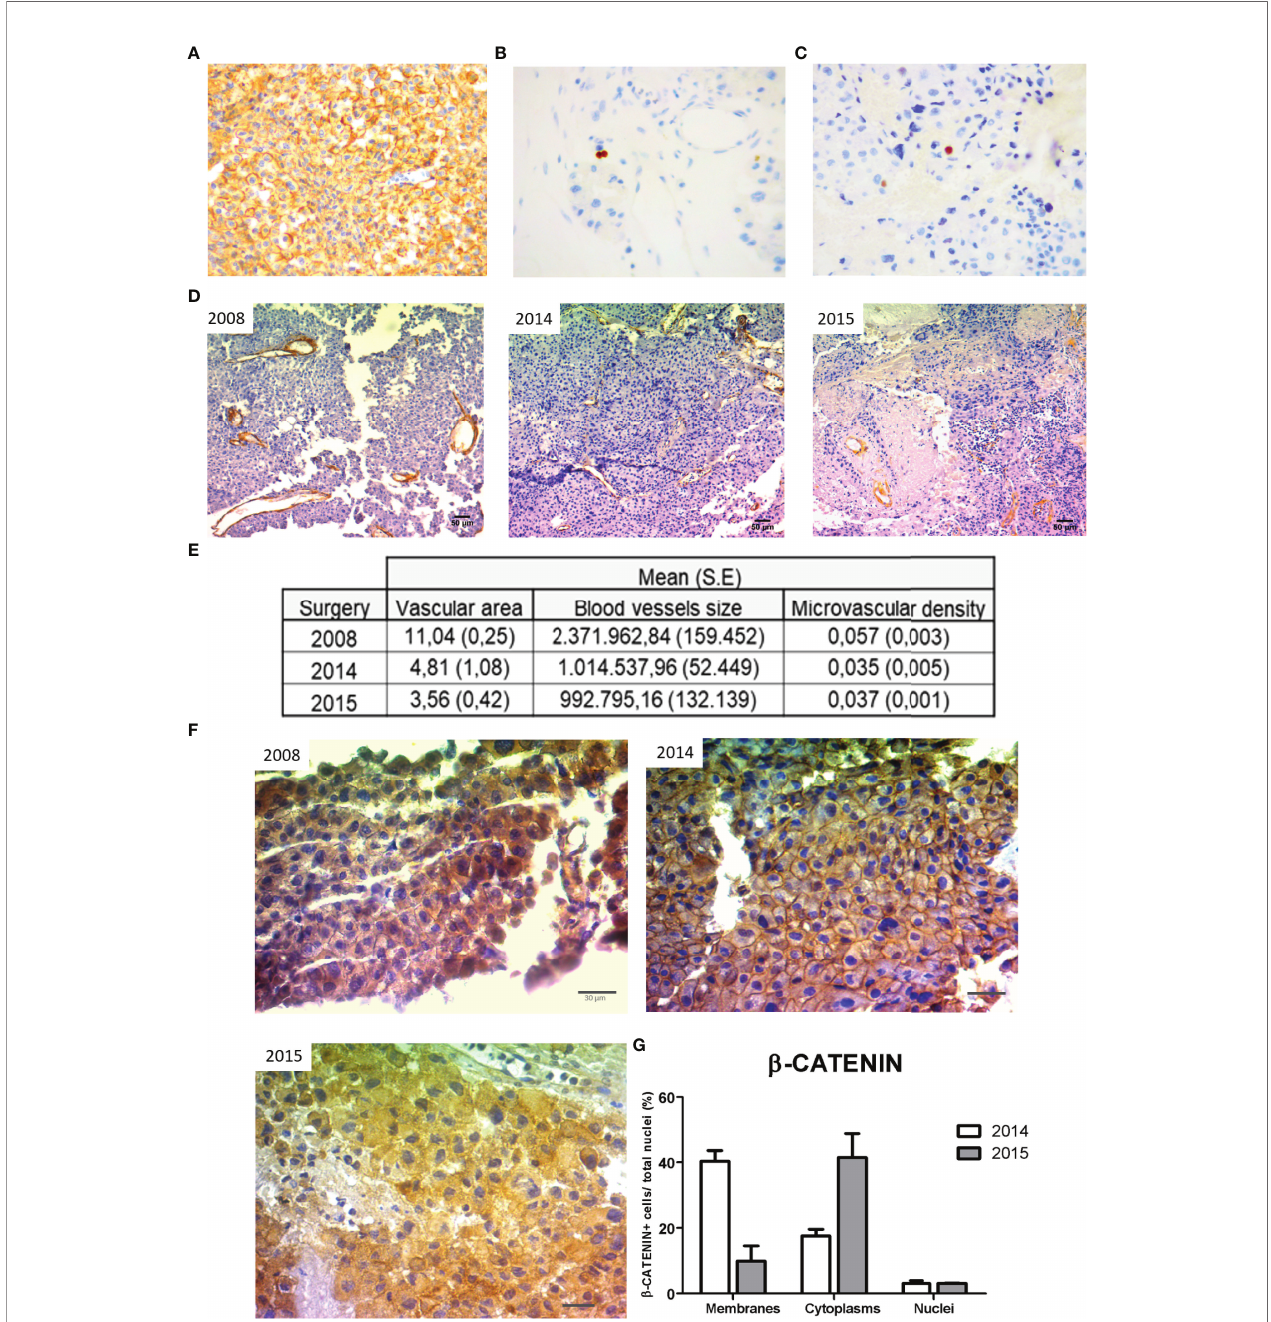
FIGURE 3 | Pathology of the different tumor samples. The excised tumor tissue from the 2015 surgery showed high ACTH IR cells (A) , increased Ki-67 proliferation index (B) and p53 immunoexpression (C) as we determined by IHC (20X, 40X, and 40X magni fi cation, respectively). (D) Representative images of immunohistochemistry (IHC) for a -SMA of each tumor specimen obtained in 2008, 2014, and 2015 surgeries, respectively (10X magni fi cation, scale: 50 µm). The vascular area (blood vessels area/total area), blood vessel size (µm2), and microvascular density (number of blood vessels/µm2) determined by a -SMA stained vessels are summarized in the table (E) . Values correspond to the mean and standard error of two different experiments of immunohistochemistry. (F) Representative images of b -CATENIN immunoexpression in tumor samples of 2008, 2014, and 2015 surgeries, respectively (40X, scale: 30µm). (G) b -CATENIN positive cells at membrane, cytoplasm, and nucleus of tumor samples from 2014 and 2015 were counted and expressed as percentages of total nuclei (mean and